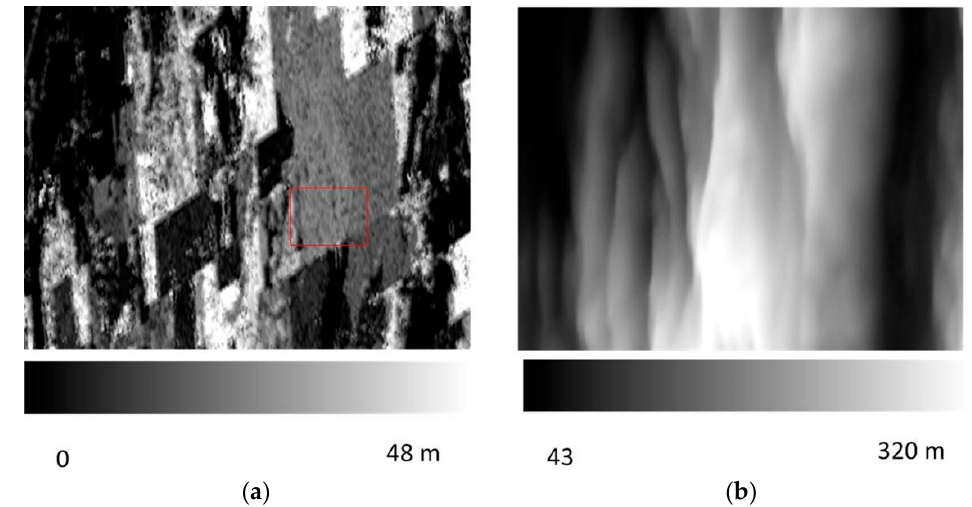
Figure 7. The CHM (canopy height model) and DEM of the statistical sample area. ( a ) CHM; ( b ) DEM.